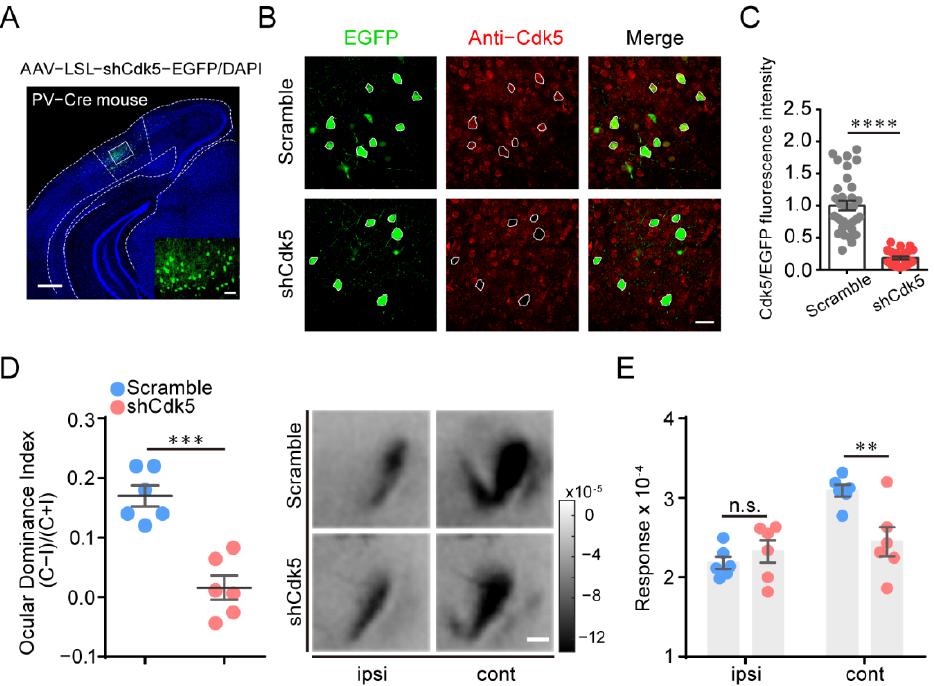
Figure 3. Cdk5 knockdown in PV neurons of V1 is sufficient to reactivate OD plasticity in adult mice. ( A ) A representative image of infected PV neurons with AAV–shCdk5. Scale bar, 500 μ m. Enlarged view shown in inset. Scale bar, 50 μ m. ( B ) IHC in V1 of PV-Cre mice, virus-infected PV neurons (green) and Cdk5 immunoreactivity (red). Virus-infected PV neurons are enclosed by white hollow circles. Scale bar, 30 μ m. ( C ) Cdk5 was quantified by immunofluorescence using Abs against Cdk5 (scramble = 1.00 ± 0.07, n = 34; shCdk5 = 0.18 ± 0.02, n = 24; t = 8.96, p < 0.0001, unpaired t -test). ( D ) Left: Optically imaged ODIs in PV-Cre mice with AAV–scramble (blue) or AAV–shCdk5 (erythrinus) expression in V1 (t = 5.74, p = 0.0002, unpaired t -test). Right: Example intrinsic optical signals seen in V1 for each eye stimulation after MD. Scale bar, 500 μ m. ( E ) After 4d MD, V1 activa- tion elicited by stimulation of the ipsilateral eye or contralateral eye from PV-Cre mice infected with AAV–scramble or AAV–shCdk5 (F(1, 20) = 3.84, p < 0.01, two-way ANOVA with Tukey’s post hoc test). ODI: ocular dominance index; MD: monocular deprivation; ipsi: ipsilateral eye; cont: contra- lateral eye. Data shown as mean ± SEM. n.s., not statistically significant, ** p < 0.01, *** p < 0.001, **** p < 0.0001.